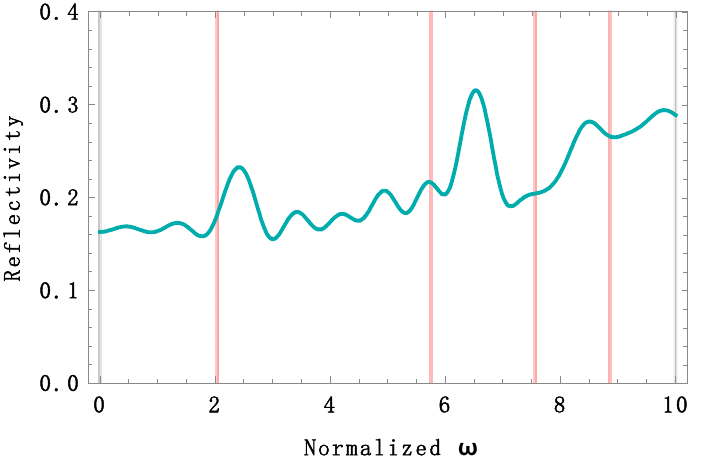
Figure 6. Theoretical reflectivity spectrum of the simulated feather for TE polarization and incidence angle of 57 ◦ . Four high reflectivity bands shifted towards the UV region. The red lines at 1237 nm, 437 nm, 333 nm, and 284 nm represented the positions of the peaks when the angle of incidence was 0 ◦ . The average reflectivity from 300 to 700 nm increased up to 21.1 ± 4.5%. A UV-chroma of 30% was calculated in the same range. The normalized frequency is given by ω = 2 π ( dl + dm ) / λ . The UV-chroma is an important parameter to measure UV light contributions to reflec- tivity. It is measured as the proportion of total reflectivity occurring within 300–400 nm.